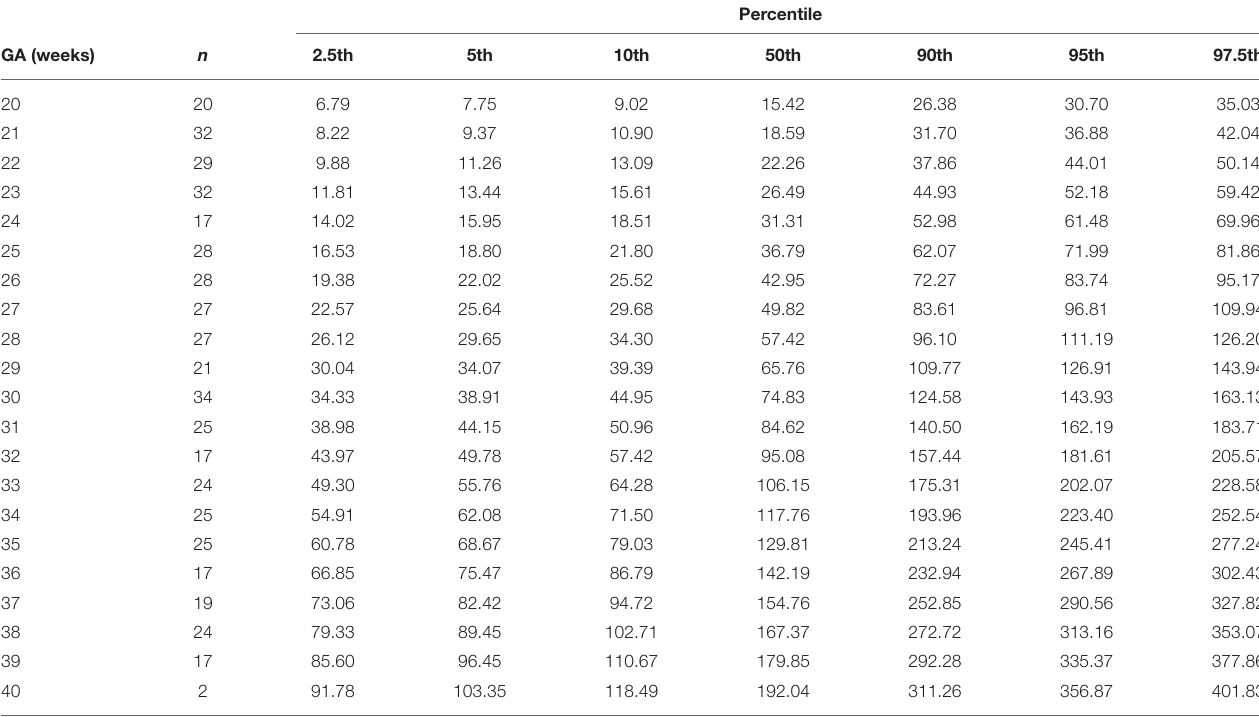
TABLE 3 | Percentiles fetal superior vena cava volume blood flow (ml/min) at 20–40 weeks of gestational age (GA).